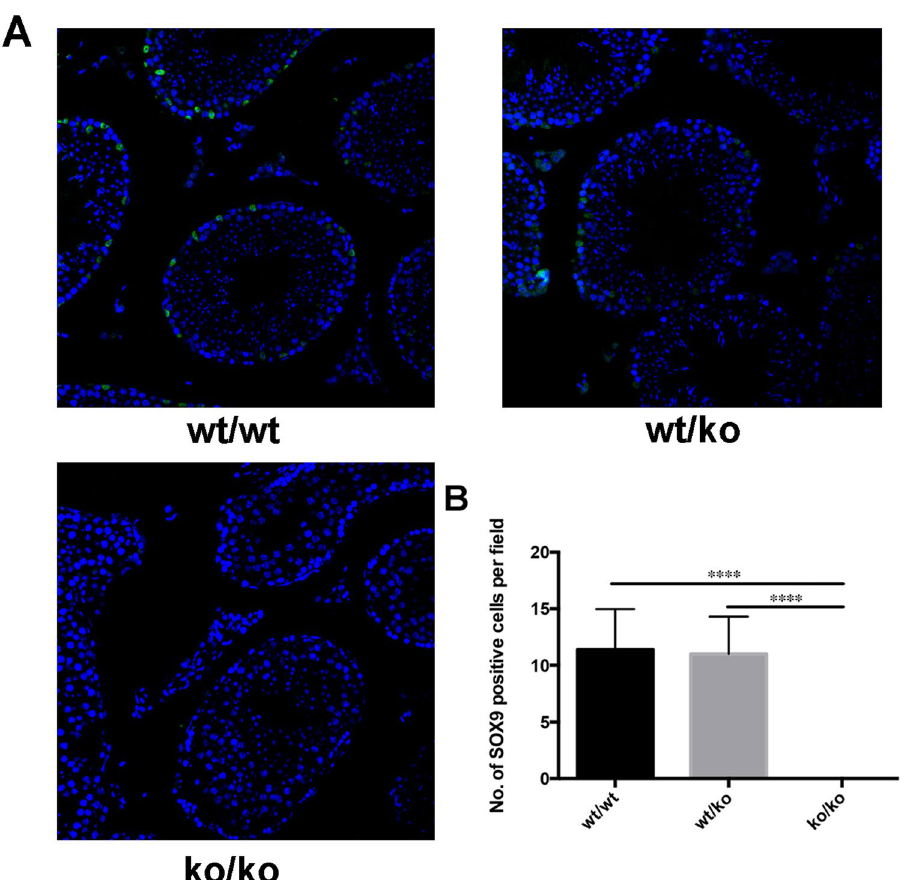
Figure 5. Absence of GGNBP2 results in impaired SOX9 expression in the testis. ( A ) SOX9 expression pattern of the testes of the three murine genotypes. From the left to the right are the testis of wild-type, heterozygous and GGNBP2 KO mice. 10 × 40, LM. ( B ) Quantification of the number of SOX9-positive cells per field (field of view at 400x magnification) in the intersecting surface of the testes. The graph shows the mean ± SEM of 5 independent fields. Statistical analysis was performed using Student’s t-test. **** P <